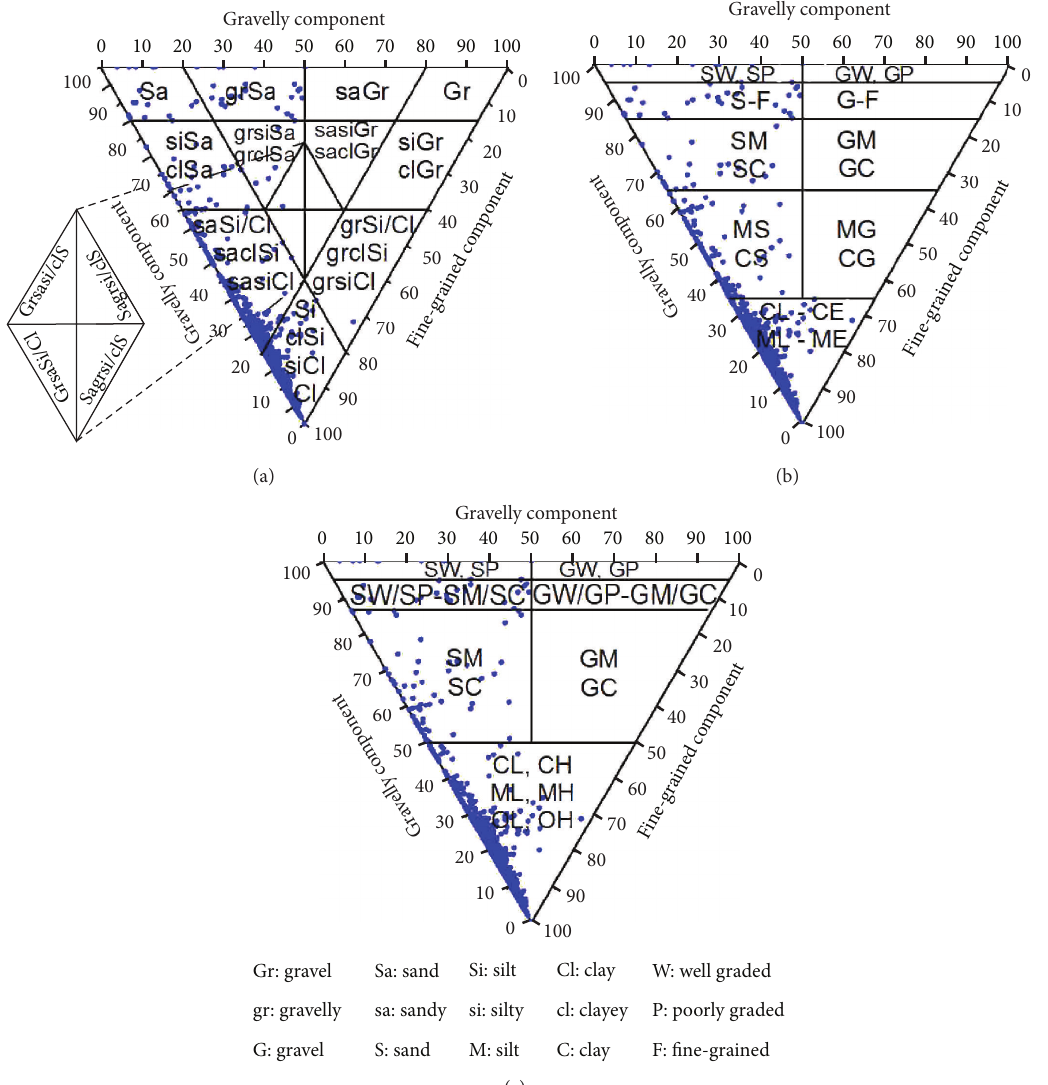
Figure 3: European, Czech, and USCS classification system of soils with marked studied samples: (a) the European soil classification system (ˇCSN EN ISO 14688-2 Standard); (b) the Czech soil classification system (ˇCSN 73 1001 Standard); (c) the Unified Soil Classification System (ASTM